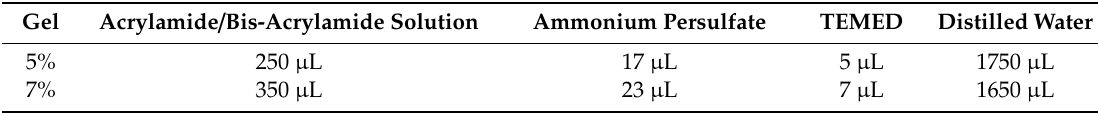
Table 2. Reagents for polyacrylamide gel